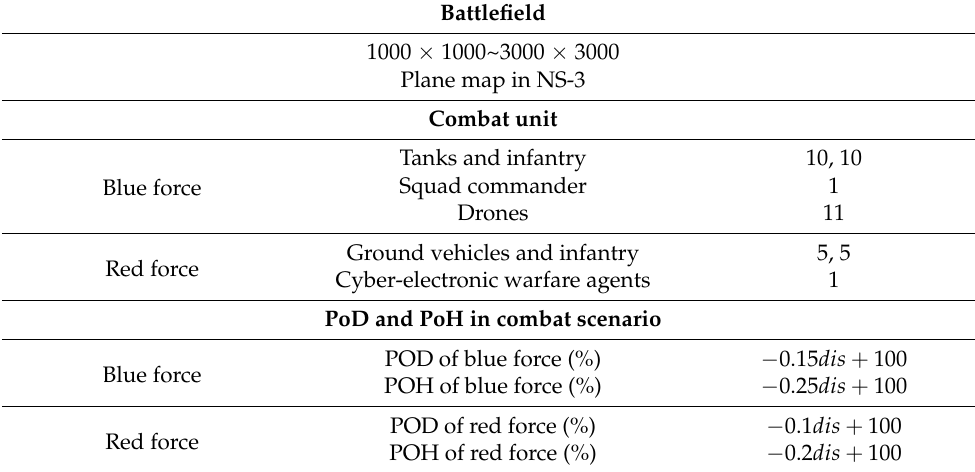
Table 4. D-CEWS (DEVS-based cyber-electronic warfare)-based battlefield simulation parameters for combat modeling each unit in blue team force and red team force.